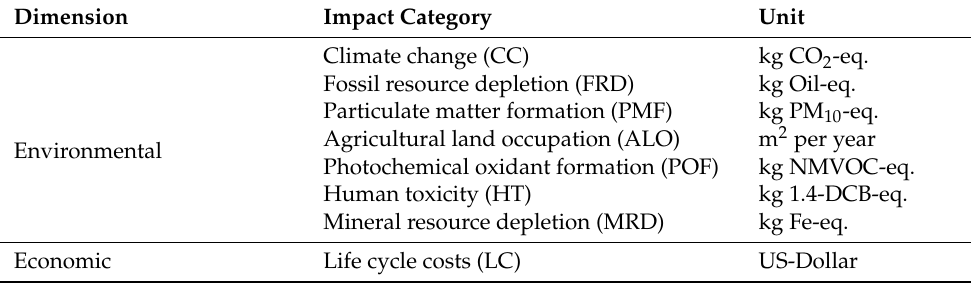
Table 2. Environmental and economic impact categories.